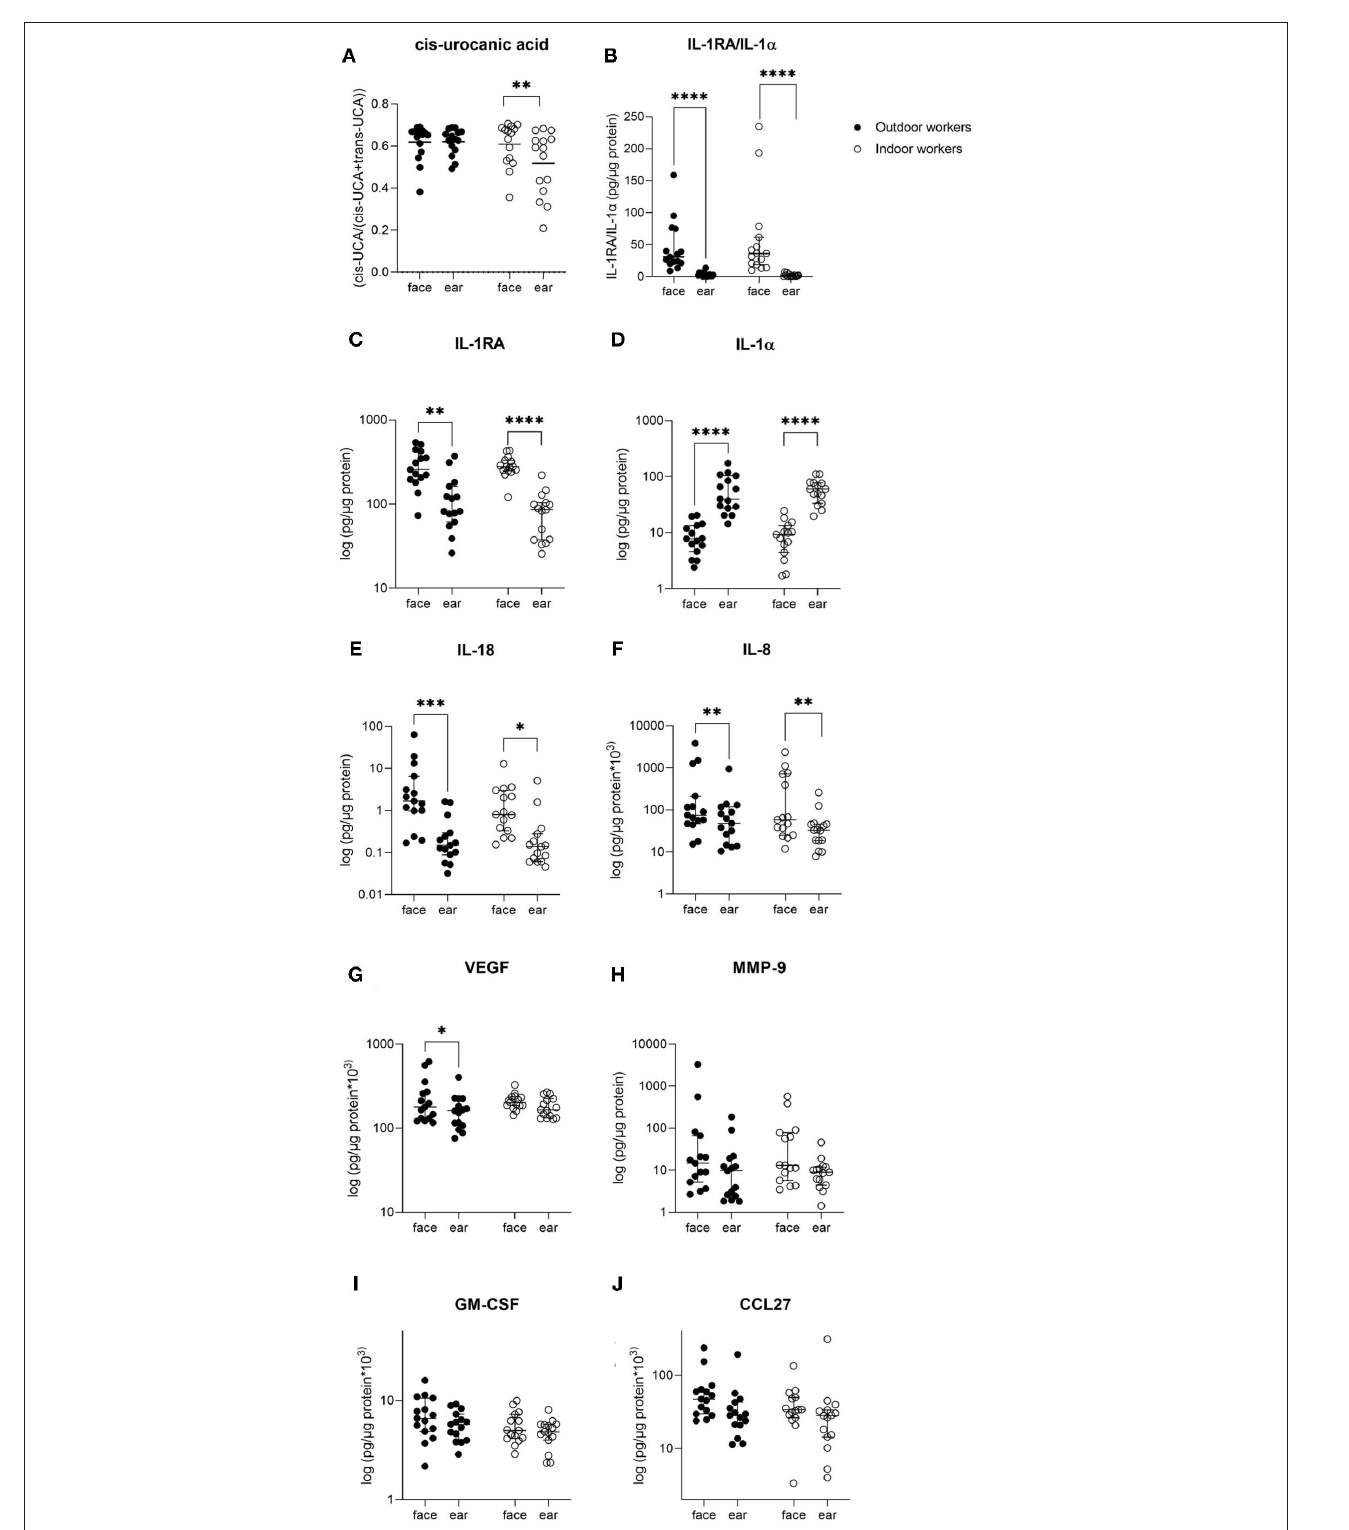
FIGURE 3 | Overview of stratum corneum concentrations of several markers measured in outdoor and indoor workers. Data are presented as median with interquartile ranges. Differences in concentrations between both groups were tested using Mann-Whitney U -test. Differences in concentrations between sample locations (forehead and ear) were tested using Wilcoxon ranking tests. * p < 0.05, ** p < 0.01, *** p < 0.001, **** p < 0.0001.